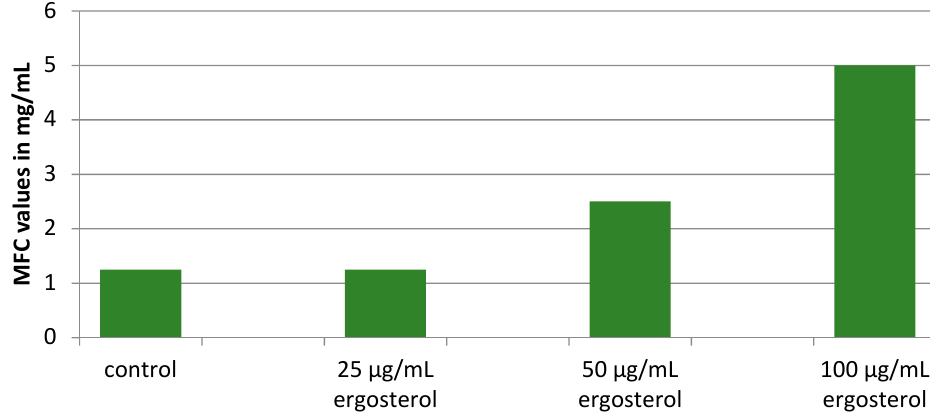
Figure 2. Minimum fungicidal concentrations (MFC) of O. spinosa methanolic extract against C. albicans in the presence of different ergosterol concentrations. There was no statistically significant difference between control sample and sample with added 25 µg/mL of ergosterol, while there was spastically significant difference between control a , 25 a µg/mL and 50 b µg/mL and 100 c µg/mL of added ergosterol ( p < 0.05), a, b, c statistically significant difference between samples.